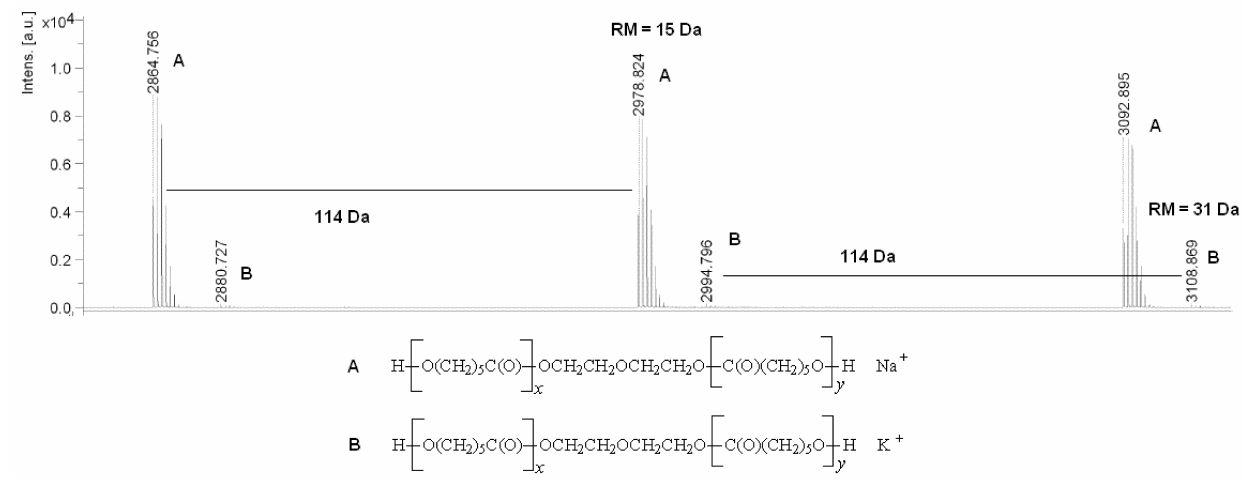
Figure 1. Matrix-assisted laser desorption/ionization mass spectrometry (MALDI-TOF MS) spectrum of poly(ε -caprolactone)